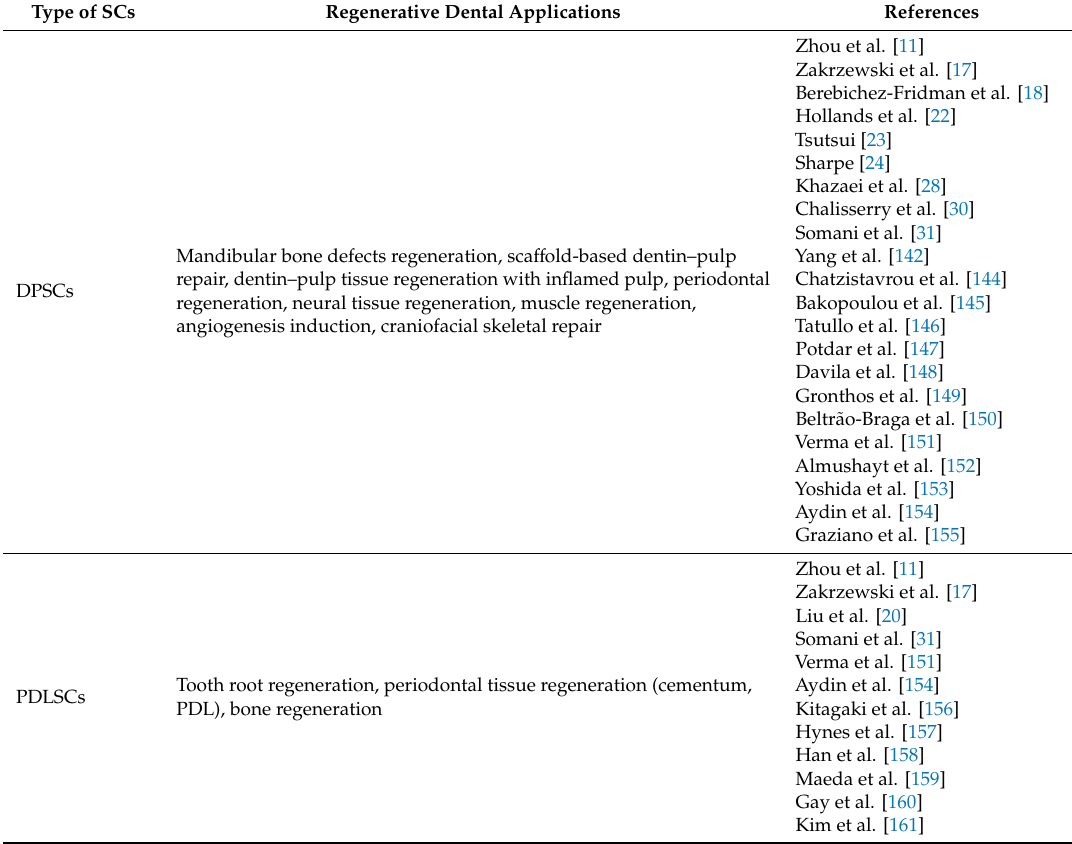
Table 2. Potential clinical applications of dental SCs in regenerative